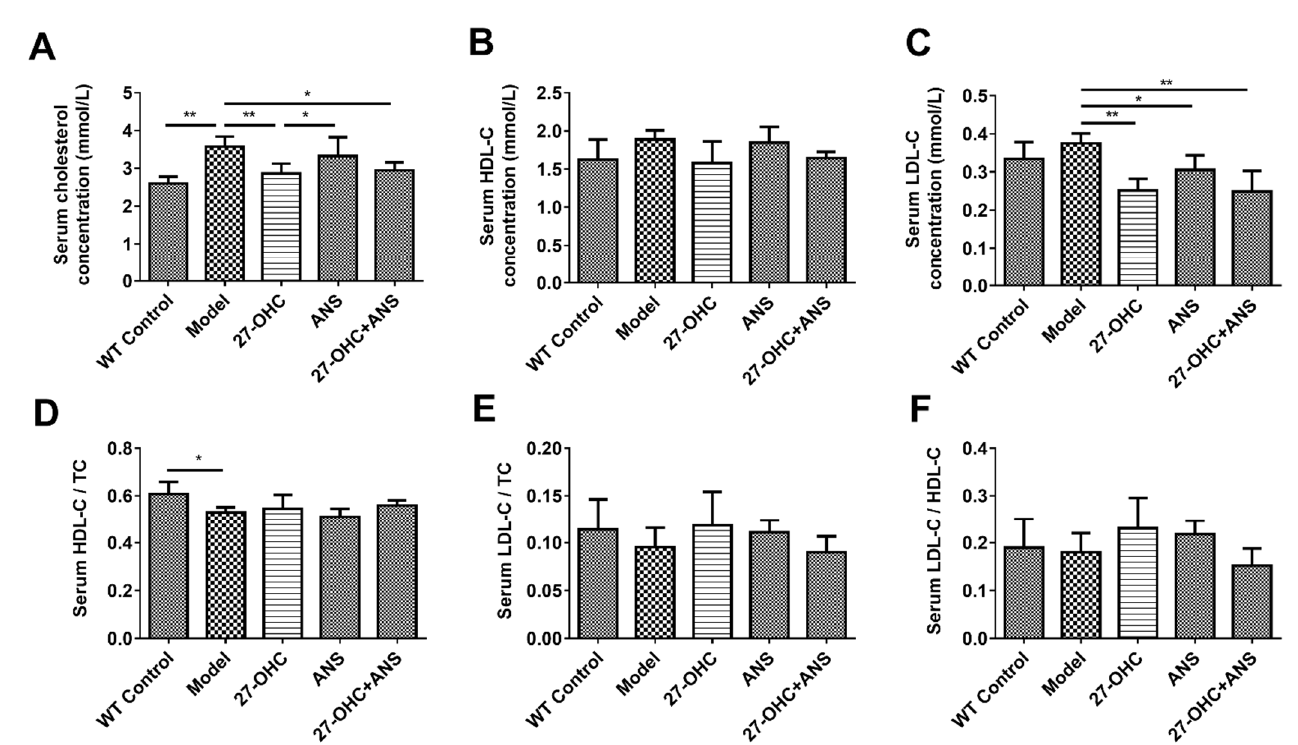
Figure 6. Serum cholesterol levels: The level of ( A ) serum TC; ( B ) serum HDL-C; ( C ) serum LDL-C; ( D ) HDL-C/TC ratio; ( E ) LDL-C/TC ratio; ( F ) LDL-C/HDL-C ratio; (n = 4/group). * p < 0.05; ** p < 0.01.